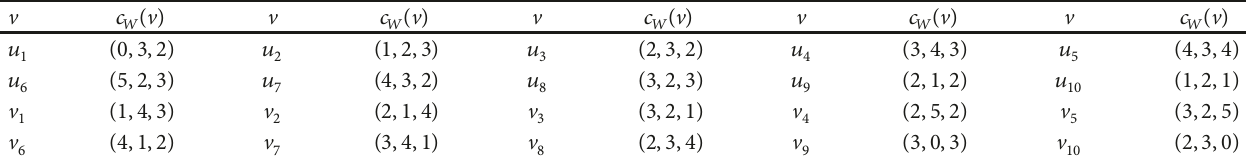
Table 2: The code 𝑐 𝑊 ( V ) of V with respect to 𝑊 = {𝑢 1 , V 9 , V 10 } in 𝑃(10, 3) .